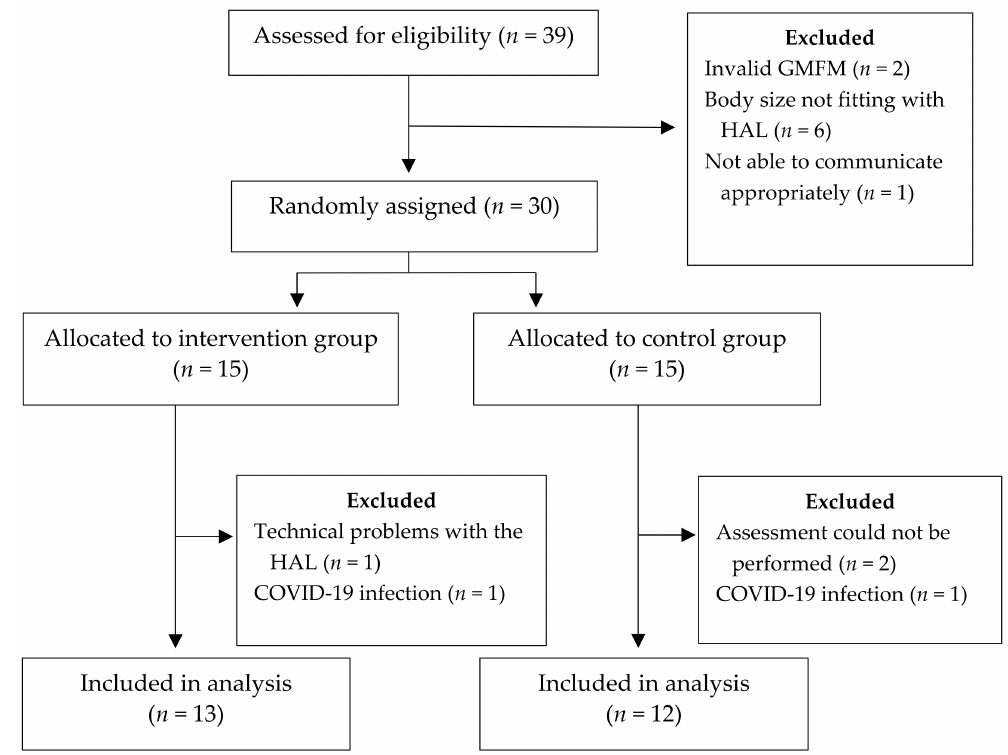
Figure 2. Flowchart of the study. GMFM: Gross Motor Functions Measure; HAL: Hybrid Assistive Limb; COVID-19: Coronavirus disease